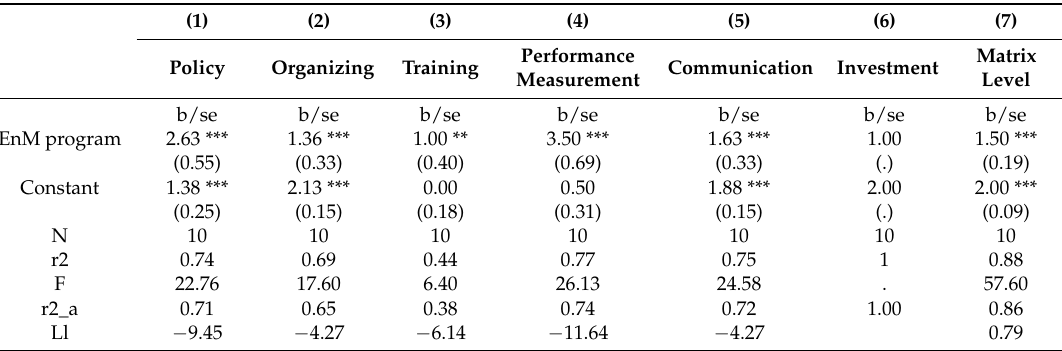
Table 3. Regression results (A) a